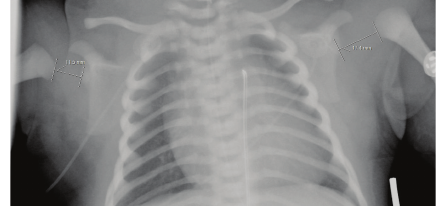
Figure 1: AP view of the chest demonstrates the ossification center of the right humerus is within the glenohumeral joint. The ossification center of the left humerus is not visualized. Additionally, the left glenohumeral distance on the left is increased compared to the right.